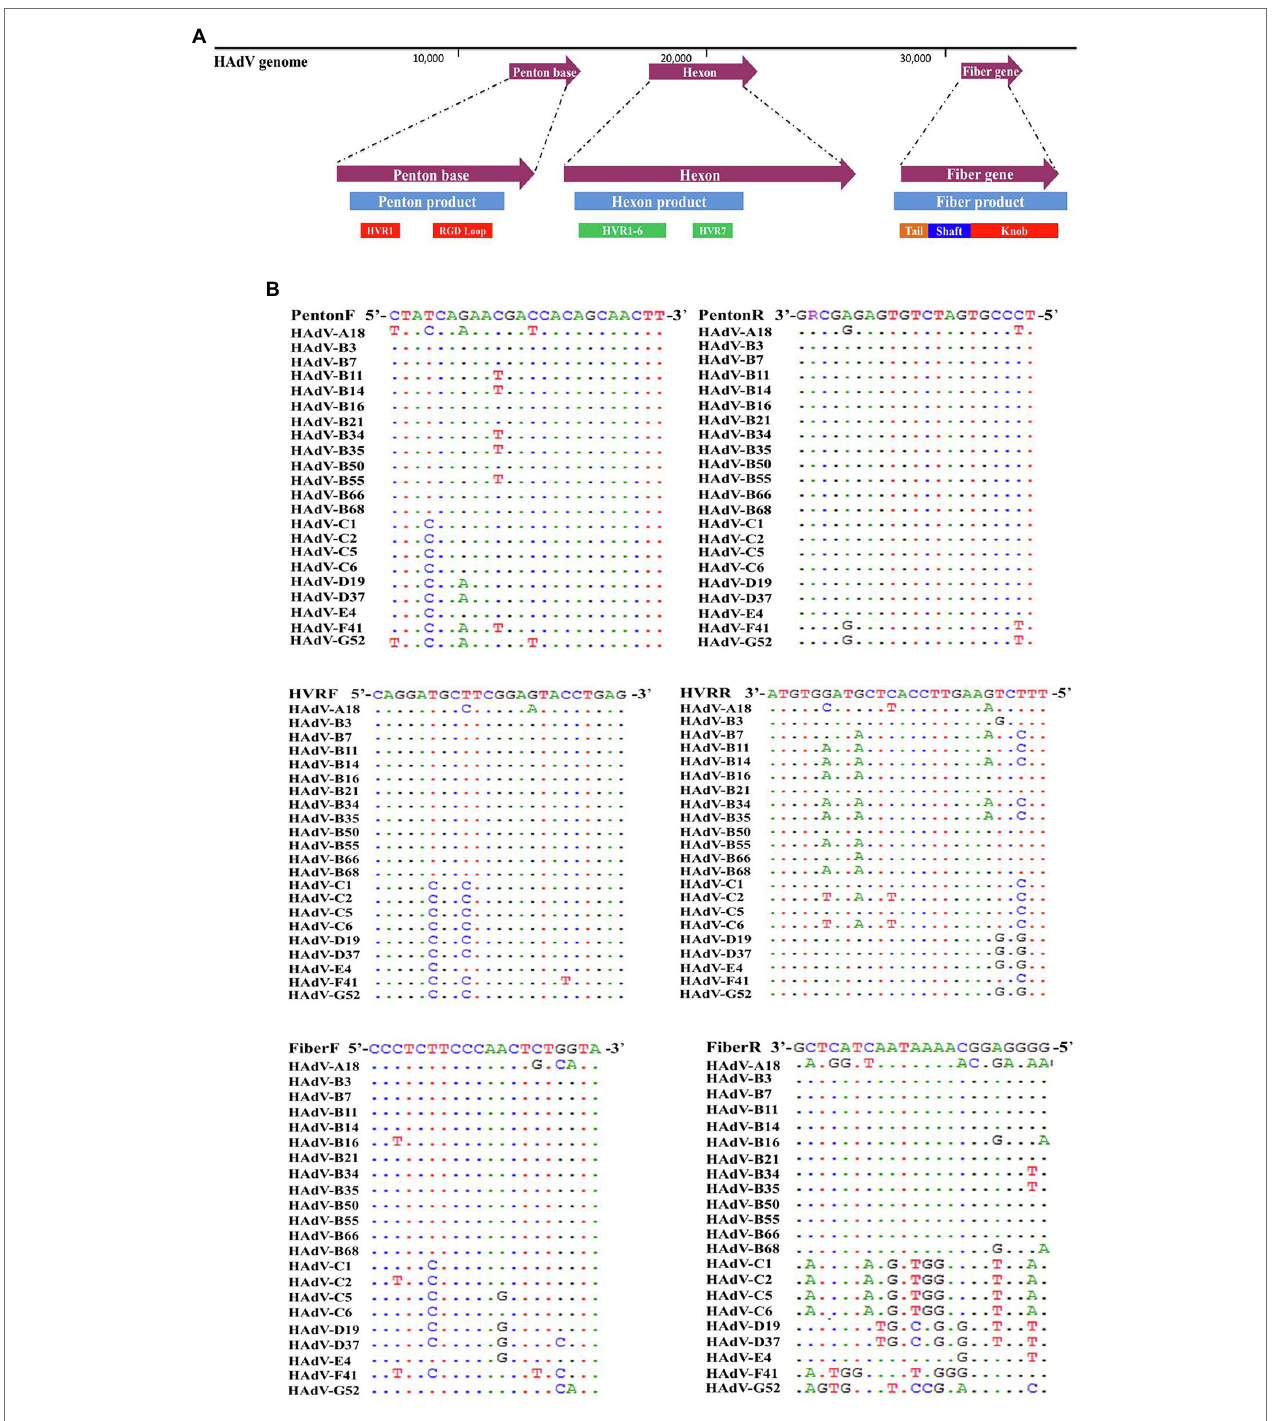
FIGURE 1 | (A) Schematic human adenoviruses (HAdV) genome, with the primer positions and the resultant PCR products noted for the three major capsid protein genes: penton base (left), hexon (middle), and fiber (right) genes. The relative locations of the capsid protein genes in the HAdV genome are also noted. These genes contain the genotyping and molecular characterization information for HAdVs. The purple arrows indicate the genes and their locations; the blue bars indicate the PCR products and their relative lengths; and other colored bars indicate important domains within each gene, including hypervariable regions (HVRs and RGD Loop), as well as the tail, shaft, and knob domains. (B) Alignment of HAdV universal primers for HAdV-A18, B3, -B7, B-11, -B14, -B16, -B21, -B34, -B35, -B50, -B55, -B66, -B68, -C1, -C2 -C5, -C6, -D9, -D19, -D37, -E4, -F41, and -G52. Divergence from the primer sequences is shown for the isolates tested. Each virus is identified with its genotype number as well as its species demarcation for reference. Dots represent identical bases, and base differences are noted. The bases are color-coded for visual